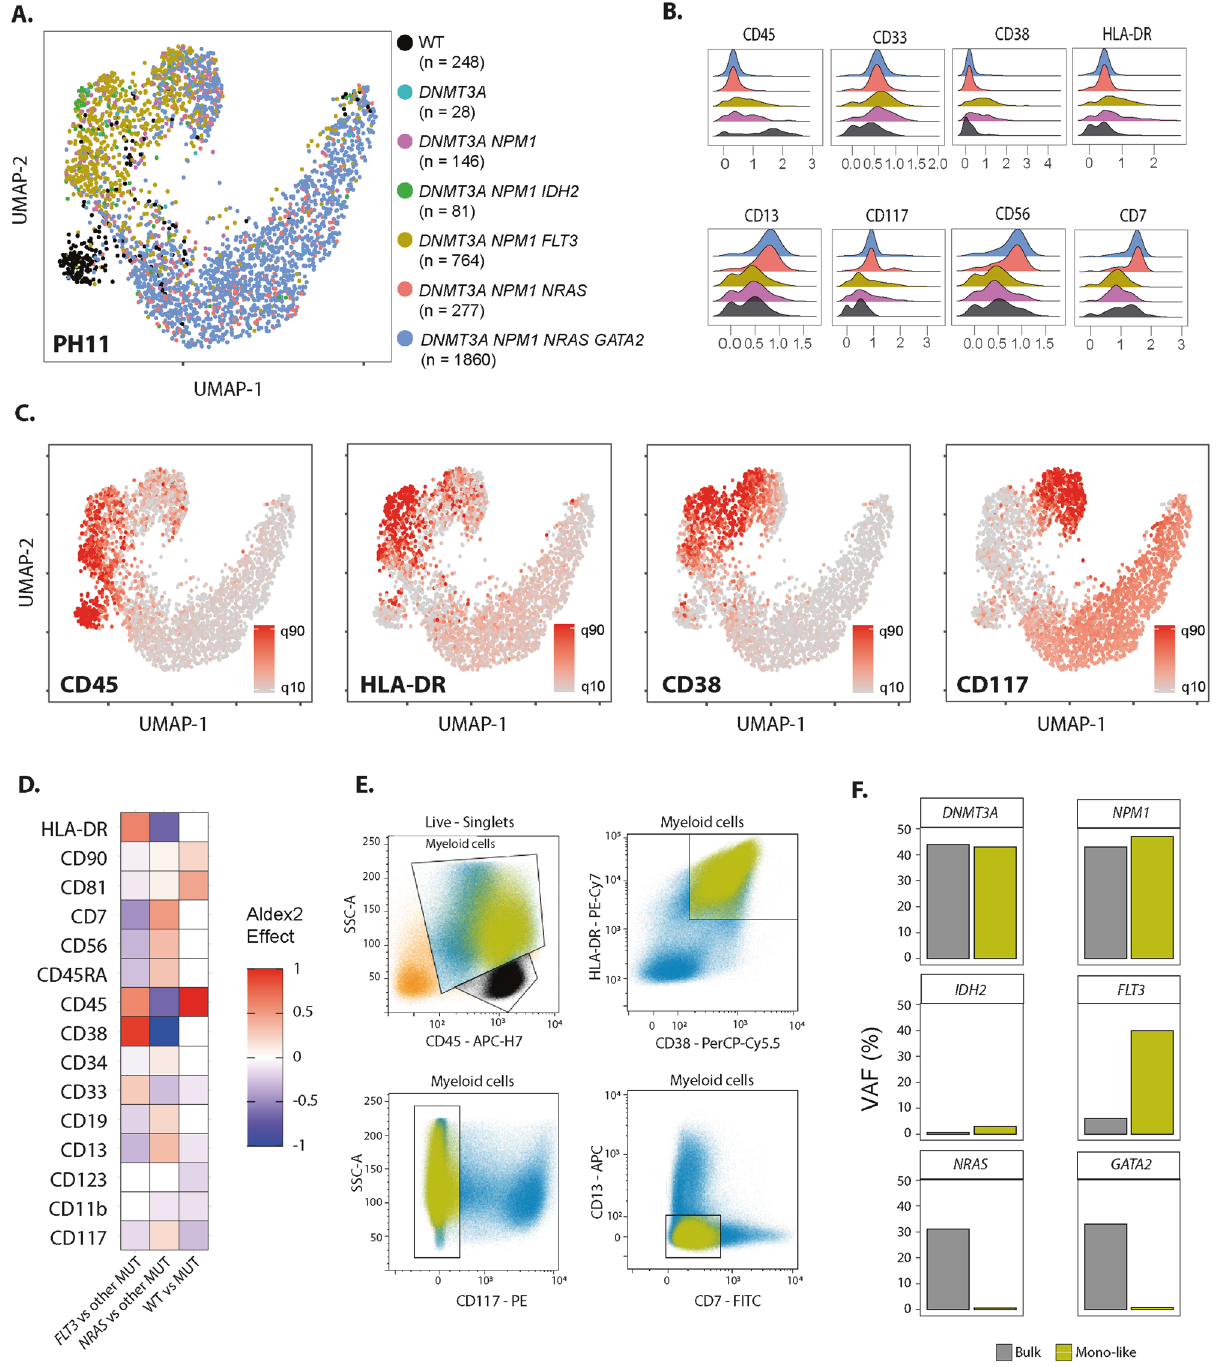
Fig. 2 Clone-speci fi c immunophenotypes in an NPM1-mutated AML. A UMAP plot of ADT-seq expression of the 3,404 single-cells from sample PH11. Cells are colored according to the genotype. B Ridge plots showing CLR-transformed expression of eight ADT according to the genotype of the cell from the PH11 sample (only genotypes with >100 cells are displayed). C UMAP of ADT-seq expression of the 3404 single- cells from sample PH11. Cells are colored according to the CLR-transformed expression of four ADT markers. D Differentially expressed ADT between FLT3 -mutated and other cells harboring at least one mutation (left), NRAS -mutated and other cells harboring at least one mutation (middle), cells with at least one mutation, and cells without any mutation (right). The size of the difference is evaluated by the Effect parameter of Aldex2, which is displayed only for differentially expressed ADT (adjusted p value <0.05). E Gating strategy for FACS sorting monocyte-like leukemic cells (Boolean: Myeloid cells and HLA-DR + and CD38 + and CD117 − and CD7 − and CD13 − ). Lymphocytes are colored black, monocyte-like cells are colored yellow, and other leukemic cells are colored blue. F Variant allelic fractions of the speci fi ed mutations on leukemic bulk (gray) and the sorted monocyte-like population